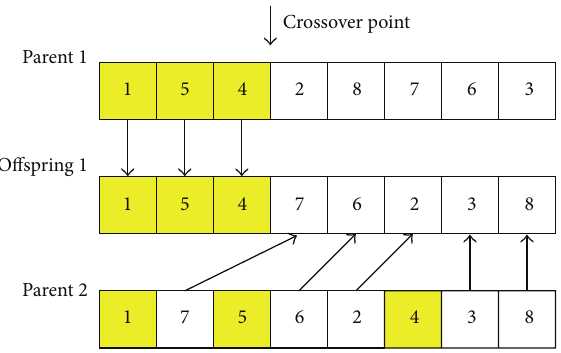
Figure 2: One-point crossover operator.